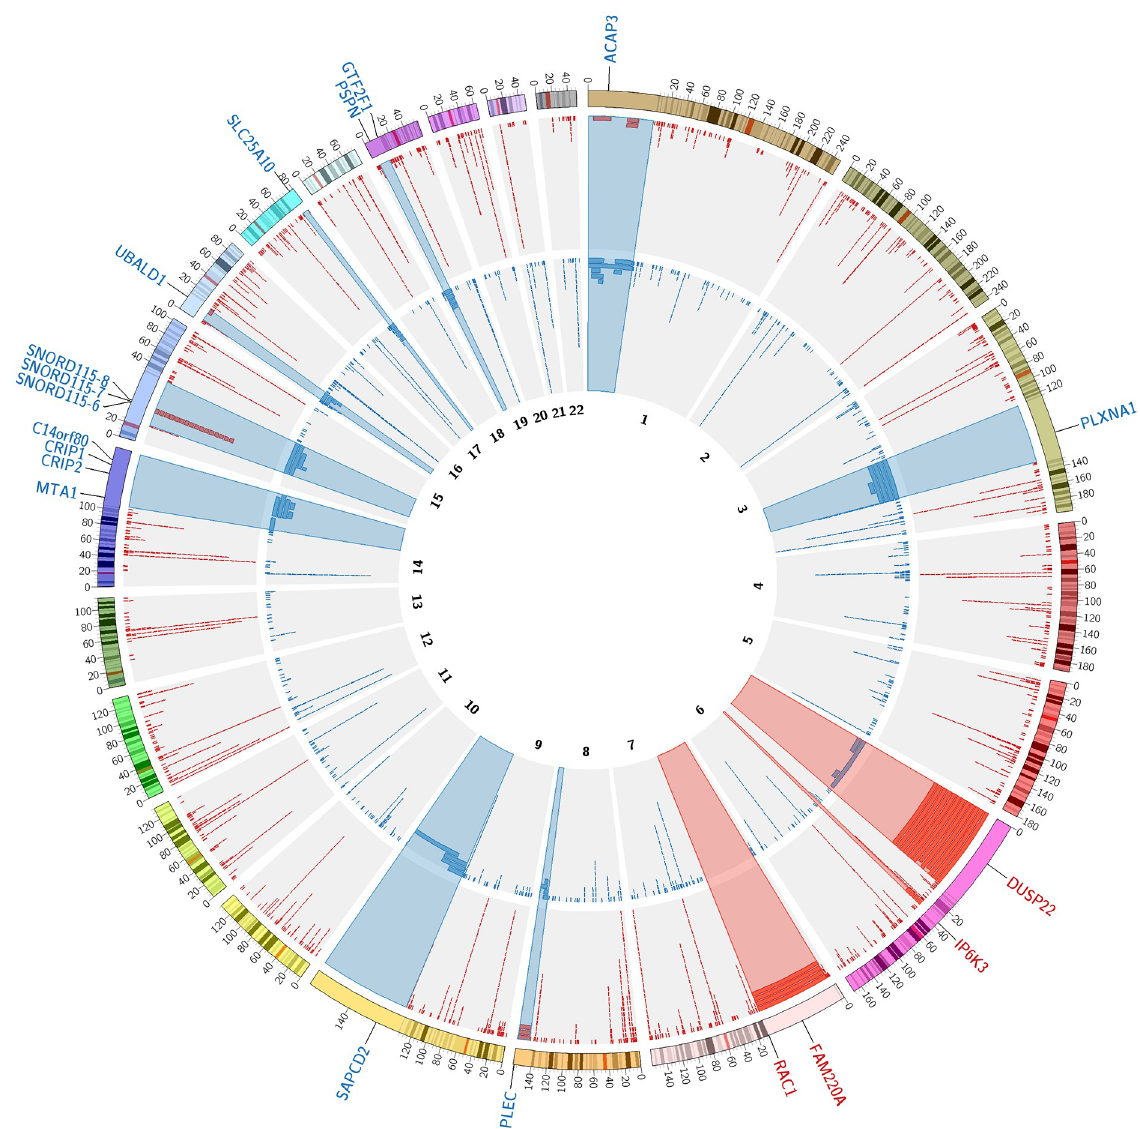
Fig 2. Chromosome view of detected CNVs. The CNVs are presented as tiles on the corresponding genomic positions. The colour of the tile indicates the CNV type: deletions are red, duplications are blue. The height of tile stack in each genomic region corresponds to the number of CNVs; if genomic region contains more than 25 CNVs, only 25 tiles are presented. The genes intersected by rare CNVs and significantly (P adj < 0.01) associated with IBD are marked by red (for deleted genes) or blue (for duplicated genes) labels; the colocated genes overlapped by the same CNVs with no significant IBD association are not presented. The regions contained the genes intersected by rare CNVs significantly associated with IBD are zoomed in 1000 times and highlighted (red and blue highlights for the associated deletions and duplications, correspondingly). The figure was built using the Circos[35] tool.